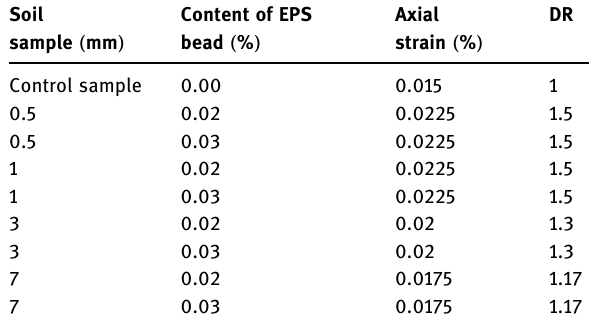
Figure 9: The stress – strain curves of di ff erent reinforcement ratios with EPS particle size of 1 mm.